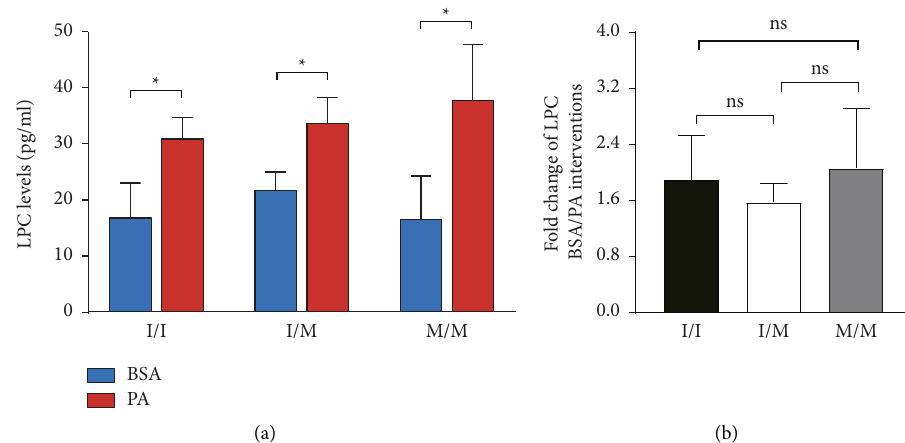
Figure 5: LPC levels of the culture cell supernatant. (a) LPC levels of the culture cell supernatant detected by ELISA. (b) Fold change (PA/BSA of (a). Biological replicates ( N � 3) were performed per group. Quantitative data are presented as the mean ± SD ( N � 3 independent experiments). ∗ P < 0 .